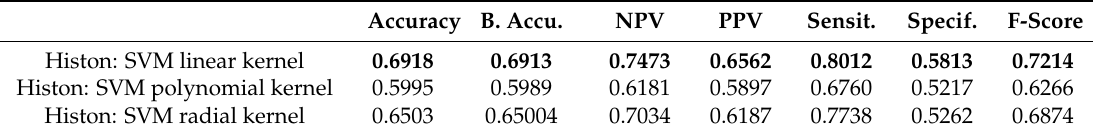
Table 3. Evaluation results showing a comparison between the mean evaluation metrics proposed from the use of different kernels (linear, polynomial and radial) for the SVM classifier for the dataset of aged 60 and over, for the 10 repetitions. The best results are highlighted in bold. Accuracy B. Accu. NPV PPV